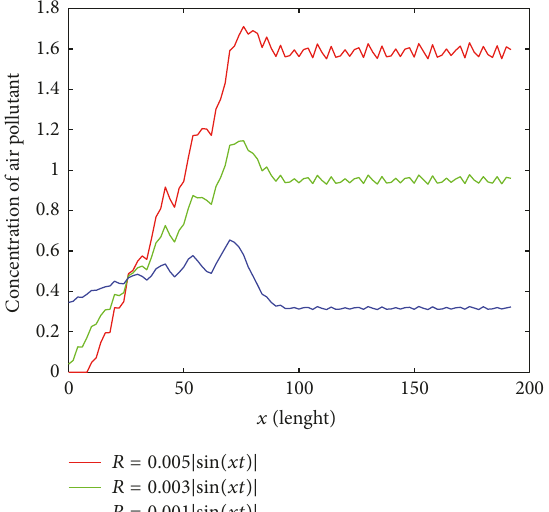
Figure 17: Compare the concentration of air pollutant where 𝑅 = 0.0 01 | sin (𝑥𝑡)| , 𝑅 = 0.0 03 | sin (𝑥𝑡)| , and 𝑅 = 0.0 05 | sin (𝑥𝑡)| sec −1 .